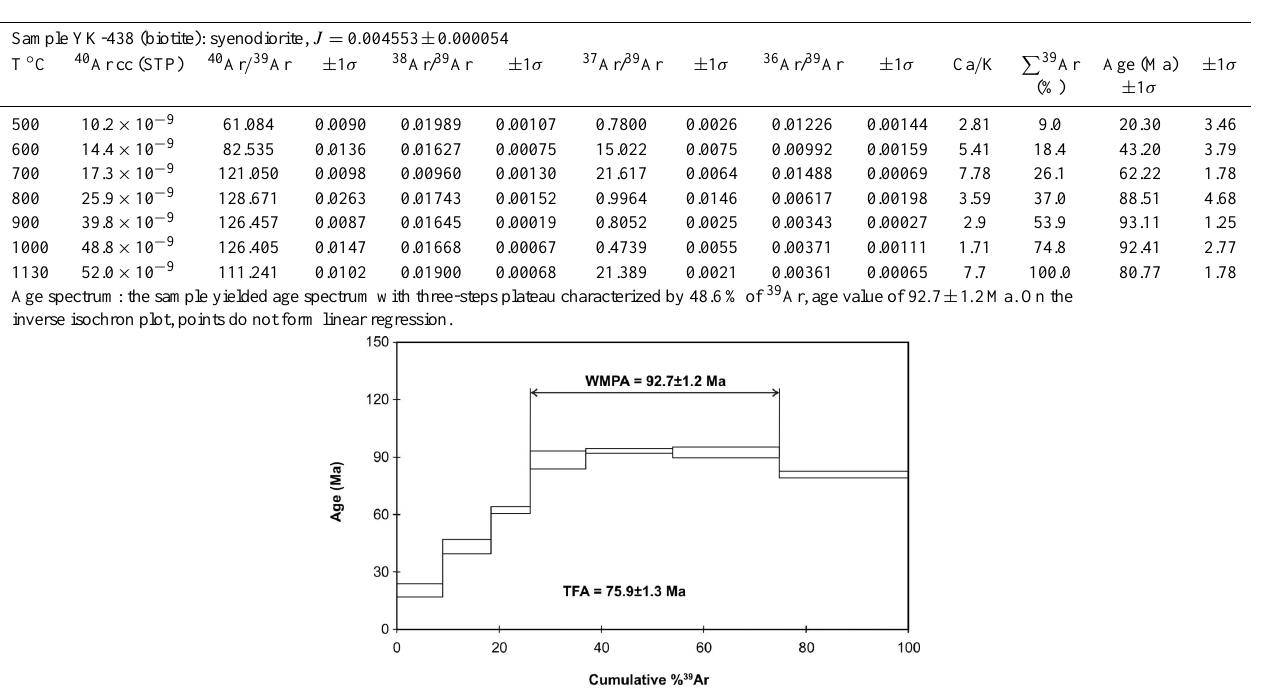
Table 4d. 40 Ar / 39 Ar biotite age data for a syenodiorite plutonic rock (sample no. YK-438) from the island arc unit in the Ankara Mélange, Turkey.